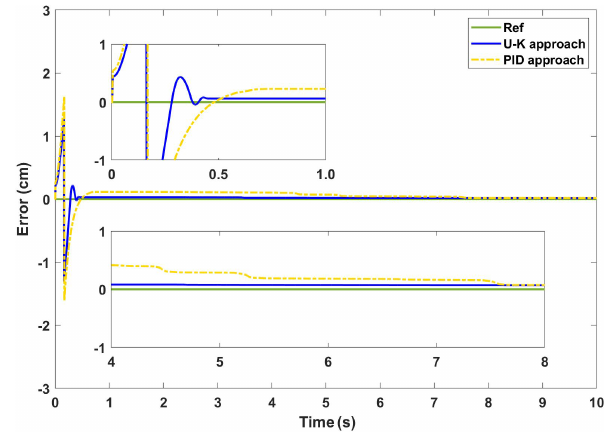
Figure 6. Experimental platform in our experiments.